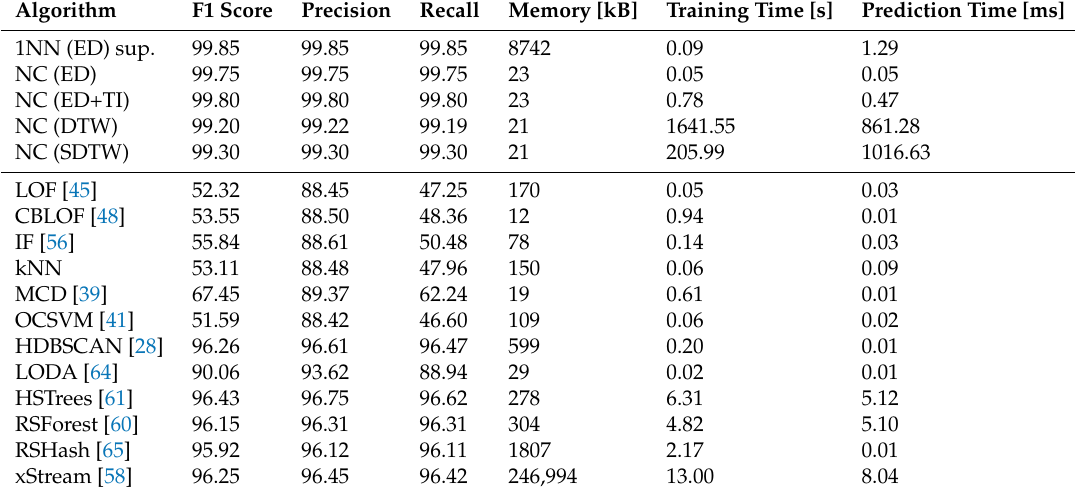
Table 1. Comparison of anomaly detection models on data set DS1 (binary labels).